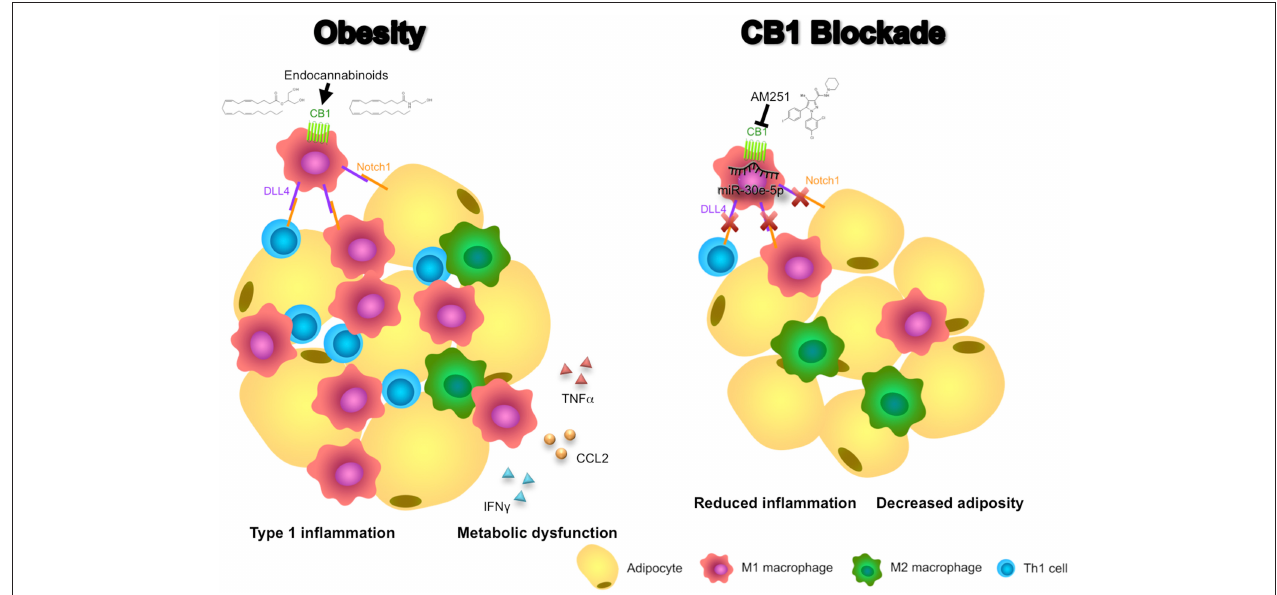
FIGURE 6 | Blocking CB1 receptors reverses obesity through miR-30e-5p regulation of DLL4. In this illustrative summary we demonstrate that blocking of CB1 receptors can reverse the inflammation and metabolic dysfunction observed in obese adipose tissue. During obesity, endocannabinoids activate CB1 to promote pro-inflammatory M1 macrophages and upregulation of DLL4. Subsequently, DLL4 activates Notch signaling on other macrophages, T cells, and adipocytes to promote M1 polarization, Th1 polarization, and adipocyte hypertrophy, respectively. As a result, pro-inflammatory cytokines and chemokines such as TNF α , CCL2, and IFN γ , and fat mass expansion, lead to metabolic dysfunction. Conversely, blocking of CB1 with AM251 reverses DLL4-Notch signaling-mediated inflammation and metabolic impairments due to upregulation of miR-30e-5p and downregulation of DLL4. As a result, fewer M1 macrophages and Th1 cells reside in the adipose tissue and energy expenditure increases to reduce fat